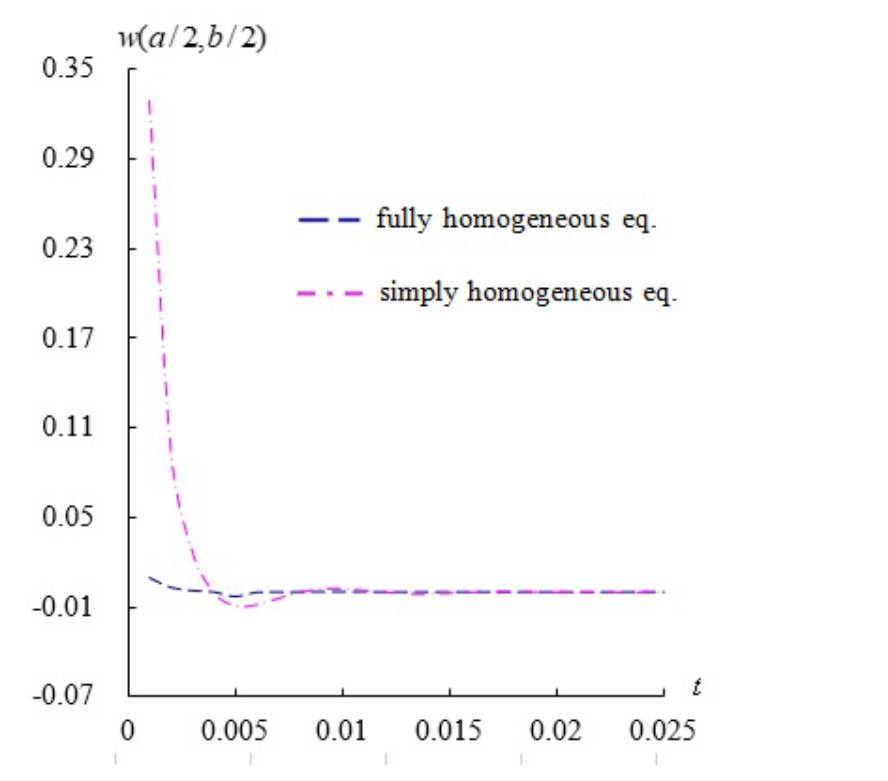
Figure 6. Transient response of w ( a /2, b /2 ) (unit mm) vs. t (unit s) compared with simply and fully homogeneous eq.